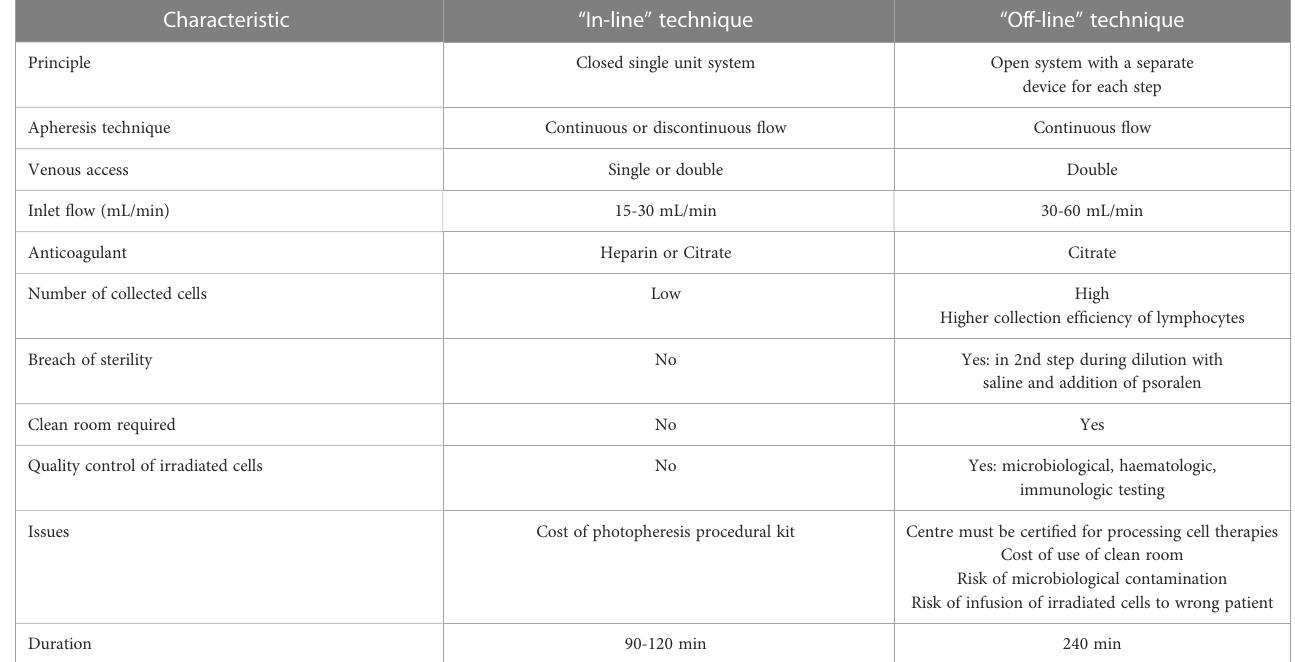
TABLE 2 Characteristics of “ in-line ” and “ off-line ”